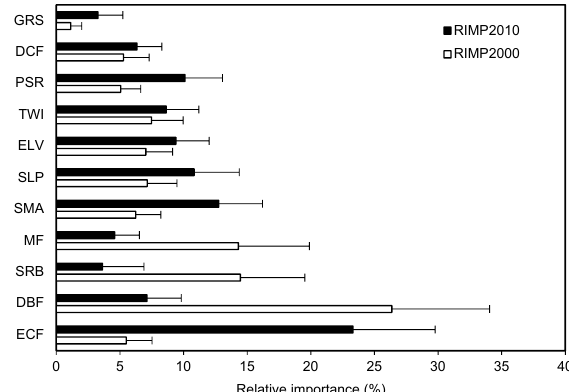
Figure 5. Relative importance proportion (RIMP) of explanatory variables for 50 boosted regression tree models (Mean + SD) of fire severity in 2000 and 2010. The y -axis (ECF to GRS) shows an overall rank of 11 variables in descending order according to a weighted average of RIMP, which is calculated by multiplying two mean R 2 (i.e., 0.830 for RIMPs of 2000, 0.738 for RIMPs 2010) with two mean RIMP values (i.e., RIMP2000 and RIMP2010) of each variable. The ECF has the highest overall relative importance while the GRS has the lowest value. See Table 2 for definition of variable